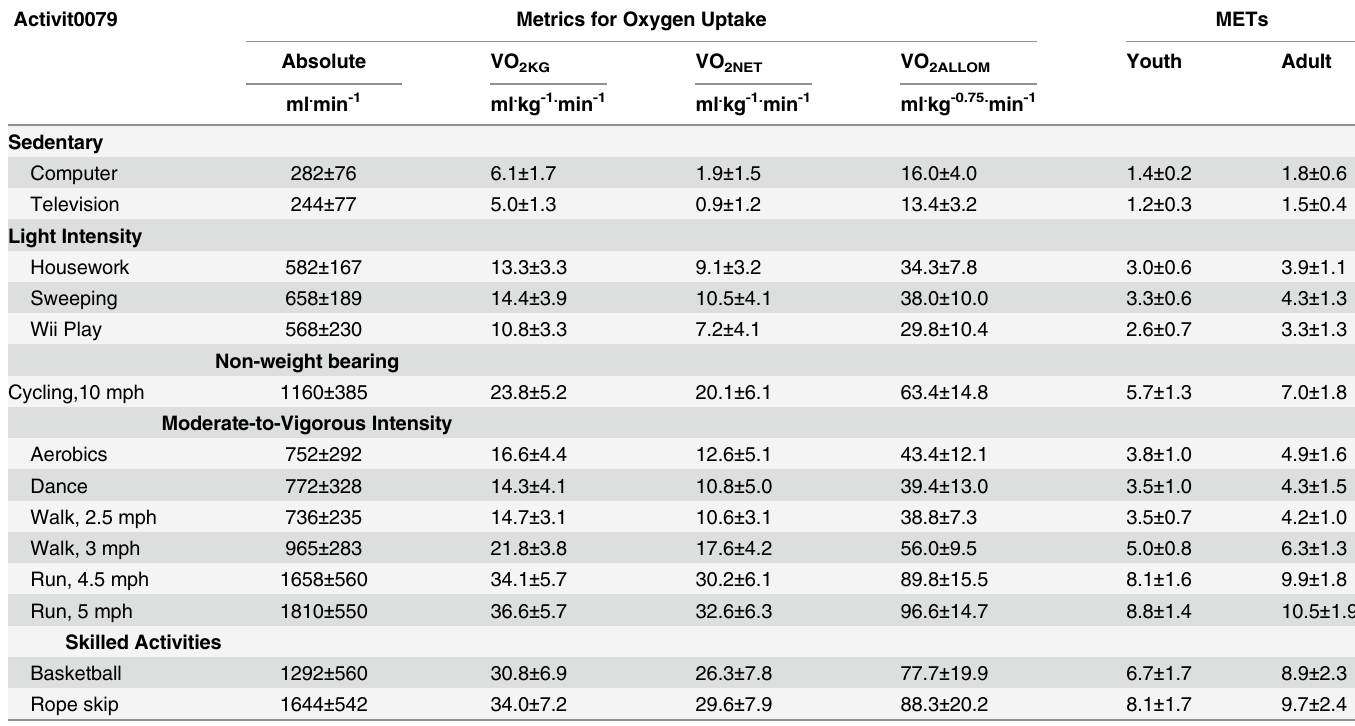
Table 3. Descriptive statistics for 14 activities, showing each metric (mean ±